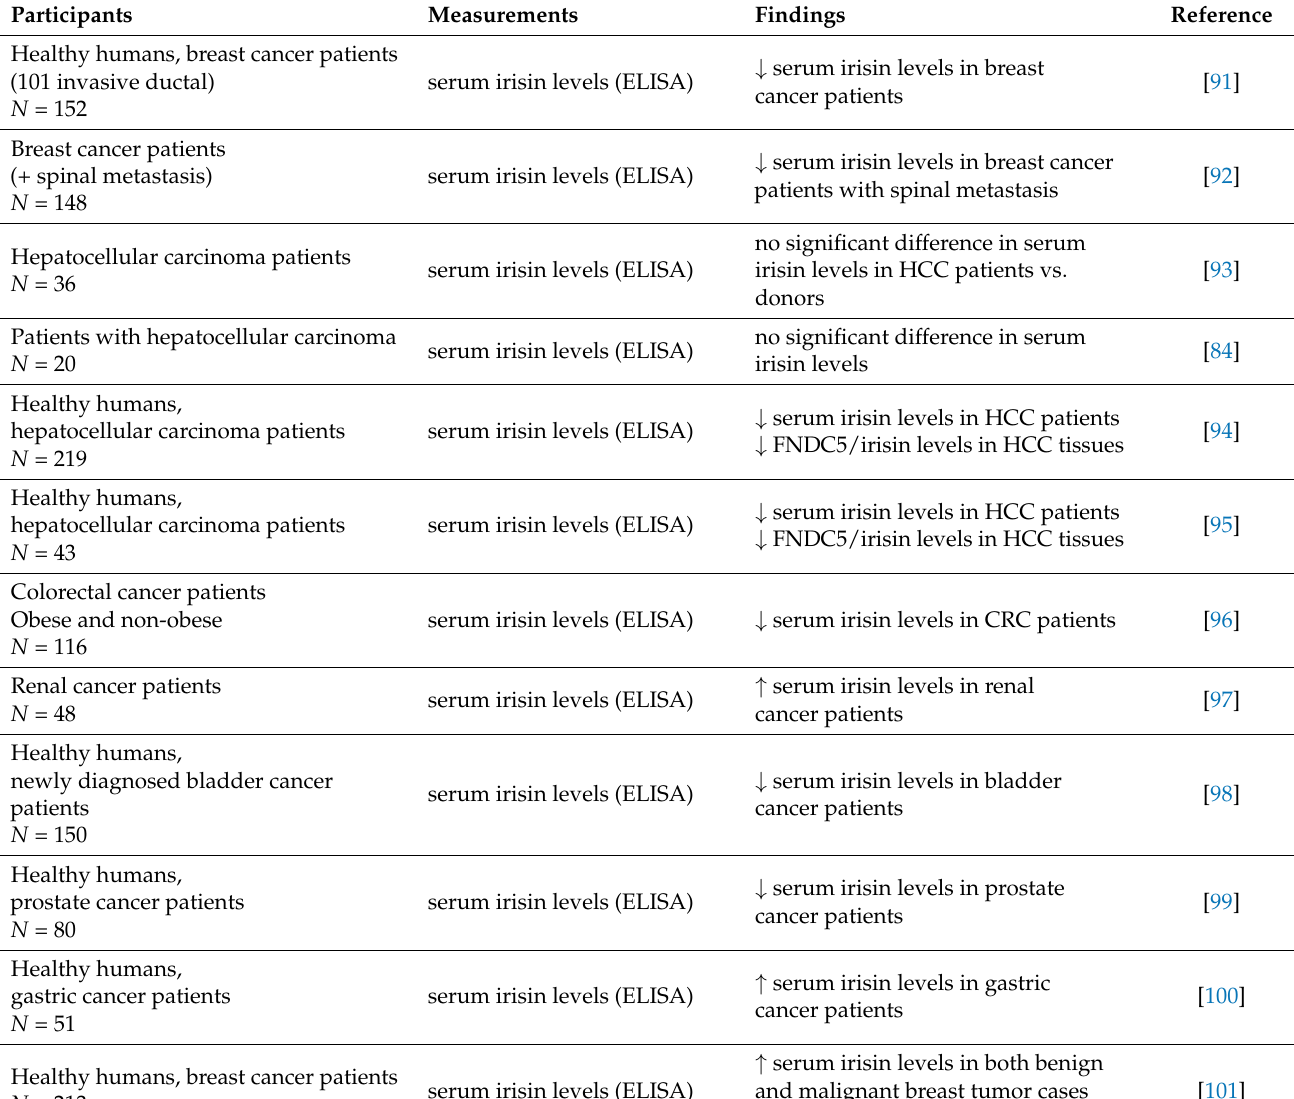
Table 3. Role of irisin in cancer: in vivo evidence from human studies measuring the serum irisin